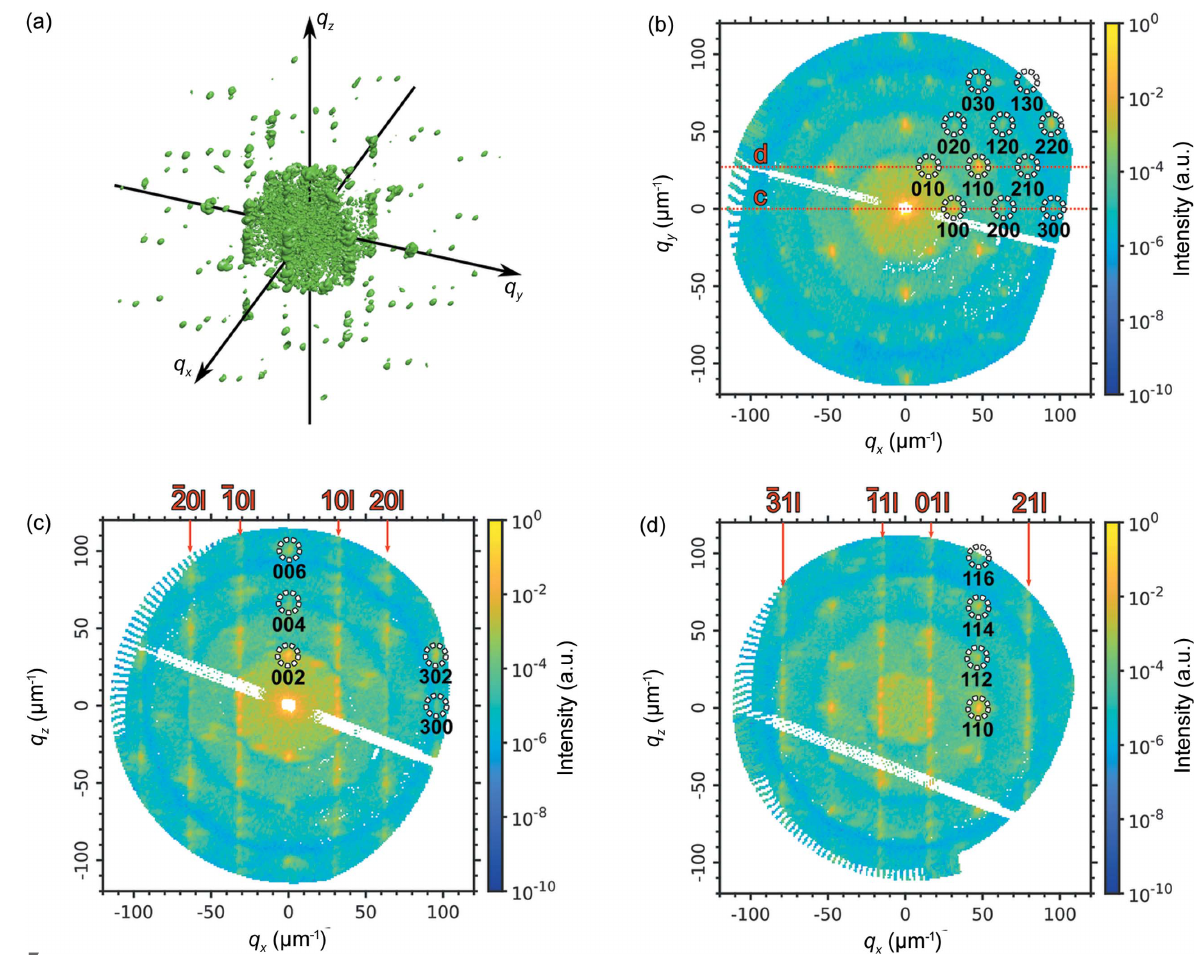
Figure 7 ( a ) Isosurface of the measured intensities in 3D reciprocal space. ( b ) Horizontal cut through the origin of reciprocal space. The Bragg peaks are attributed to an h.c.p. lattice. The red lines show the cuts in the panels ( c ) and ( d ). ( c ) Vertical cut through the 100 and 100 reflections, and the origin of reciprocal space. ( d ) Vertical cut through the 010 and 110 reflections with an offset of 30.5 nm (cid:2) 1 along q y from the origin of reciprocal space. The Bragg rods connecting the Bragg peaks of the 10 l , 20 l and 21 l families are indicated with red